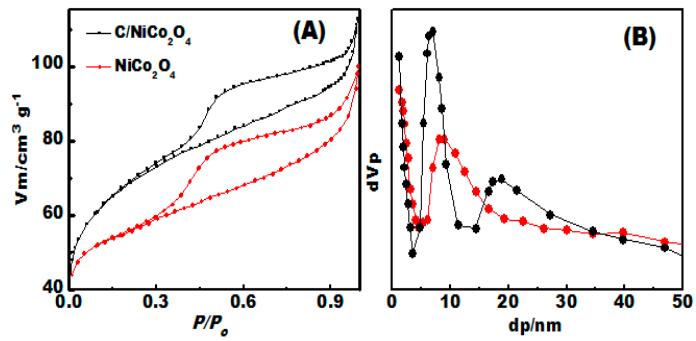
Figure 5. ( A , B ) Surface area and porous structure analyses: ( A ) N 2 -adsorption/desorption isotherms collected at 77 K; and ( B ) corresponding pore size distribution curves measured by NLDFT approach.